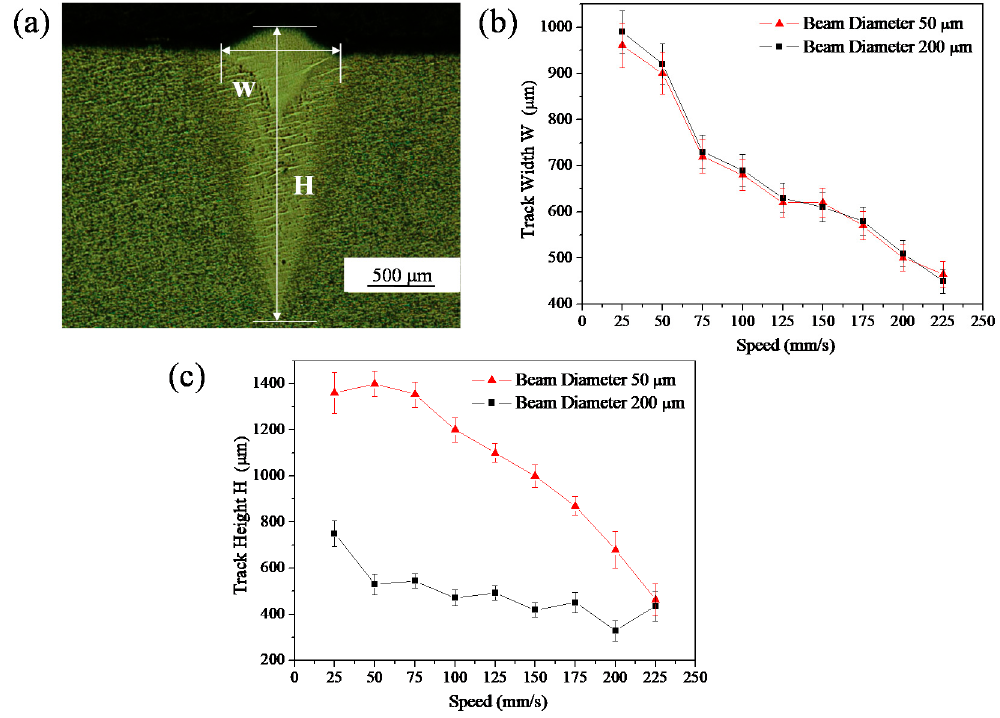
Figure 7. ( a ) Measurement of the cross-section of the scan track geometry; ( b , c ) Geometrical characteristics of the single tracks as a function of scanning speed for different beam diameters.